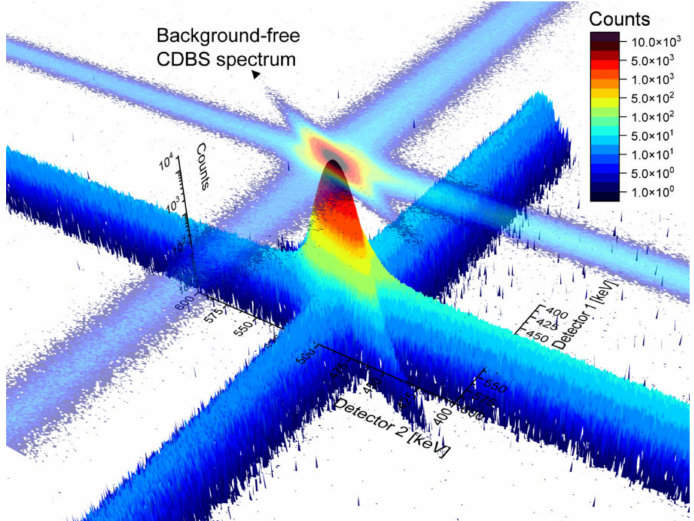
Figure 5. CDBS spectra obtained on defect-free Fe in a three-dimensional plot and two-dimensional projection. The elliptical region extending diagonally with E D1 + E D2 = 1022 keV is virtually back- ground